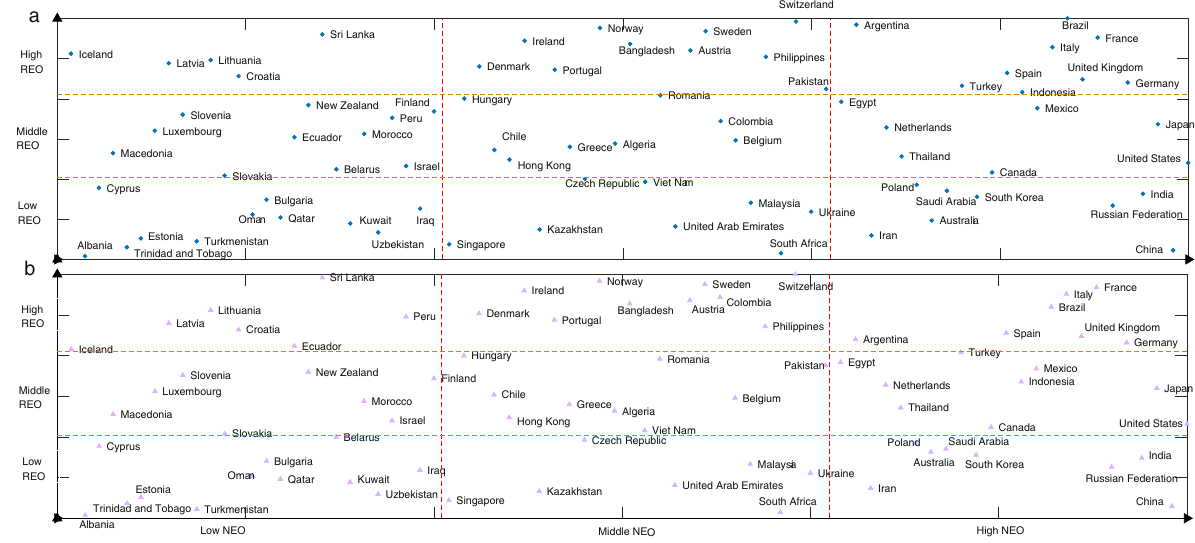
Fig. 3 9 classi fi cations of 77 low-carbon economies in terms of the average neo and reo during 2002 – 2019. a classi fi cations and rankings of 77 low- carbon economies considering the impact of net primary productivity. b Classi fi cations and rankings of 77 low-carbon economies without the impact of net primary productivity.